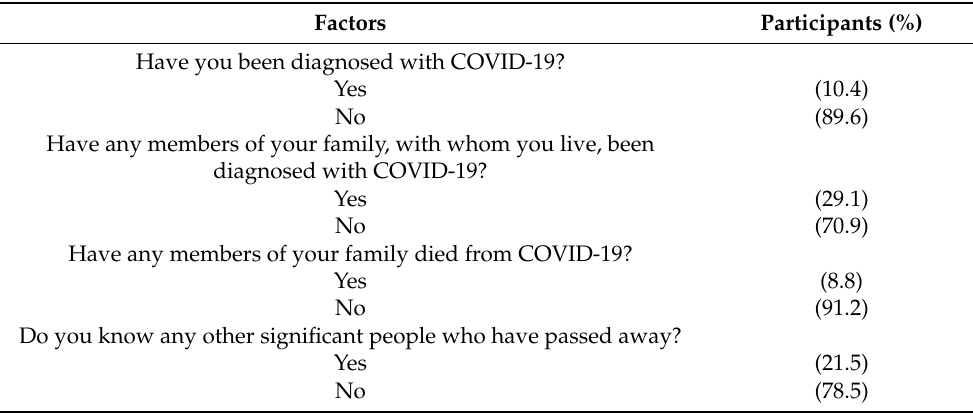
Table 2. Descriptive statistics and pandemic-related information for the total sample.